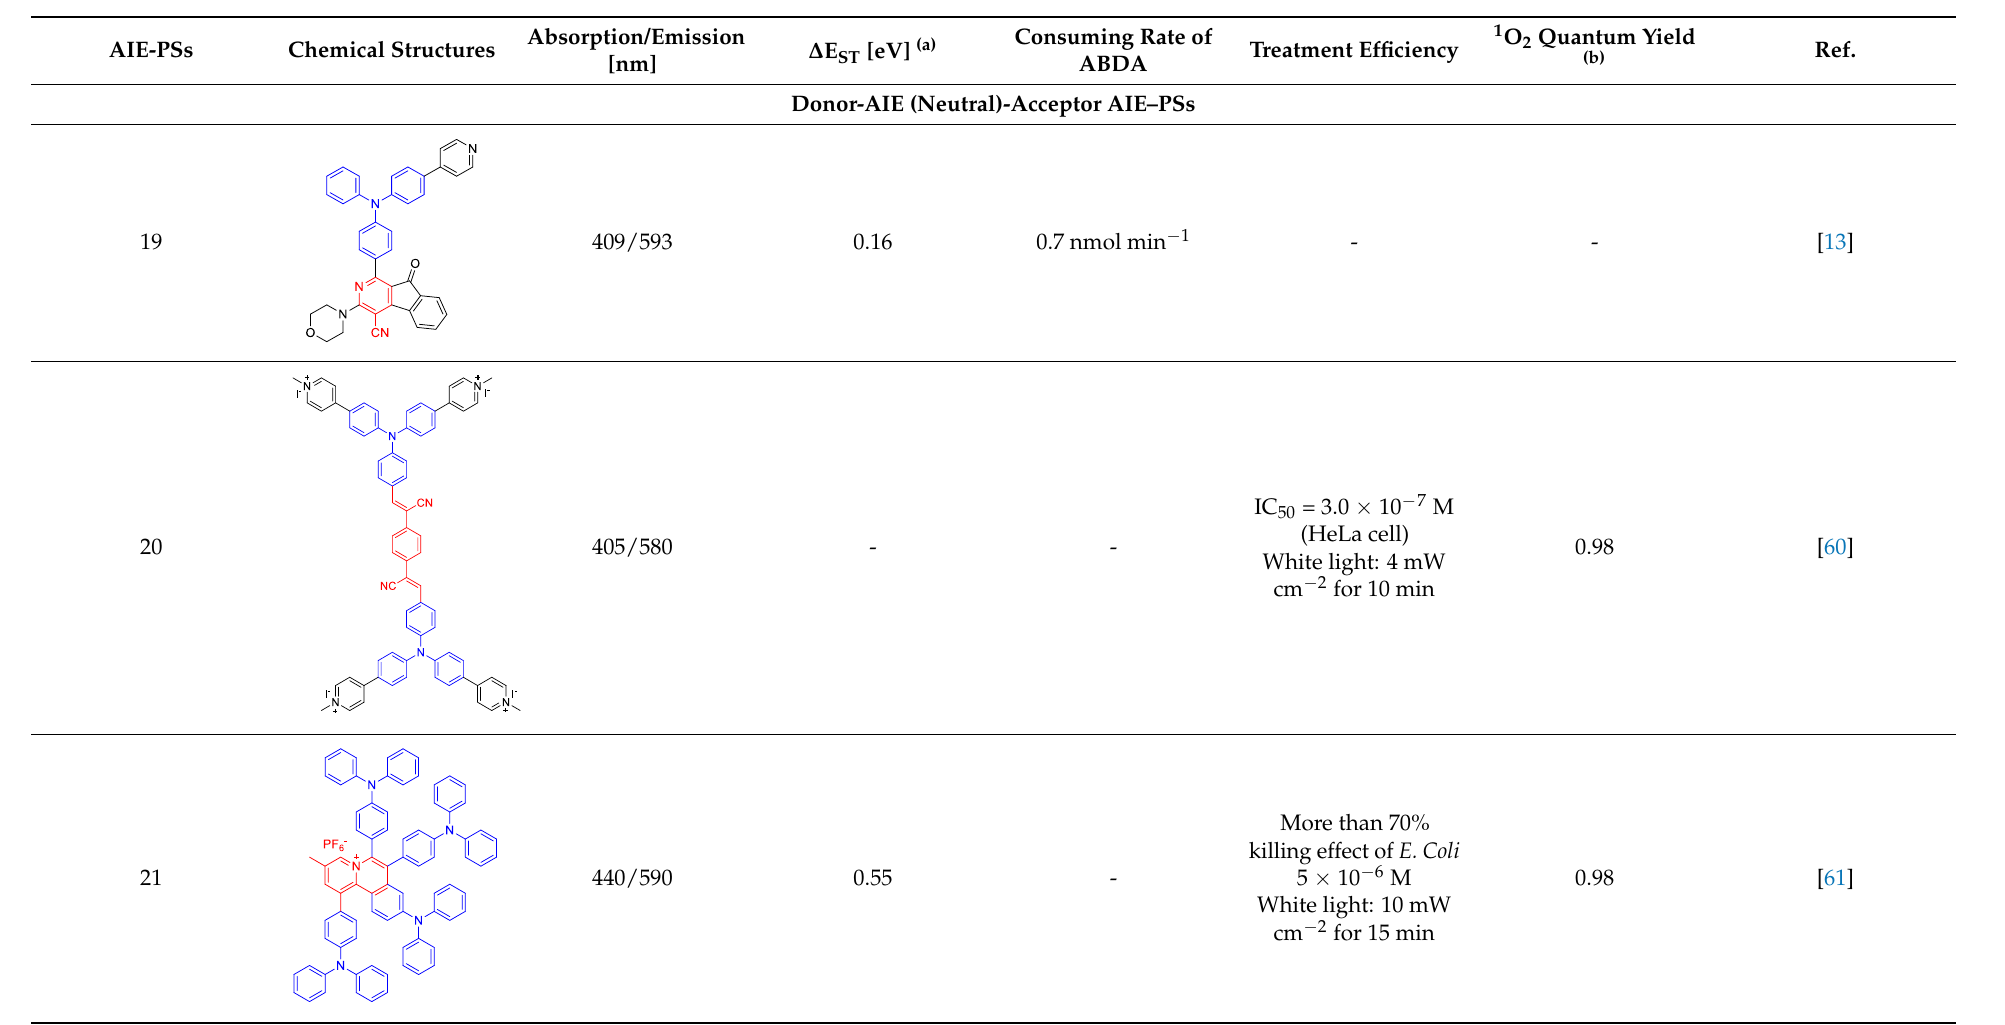
killing effect of E. Coli 5 × 10 − 6 M White light: 10 mW cm − 2 for 15